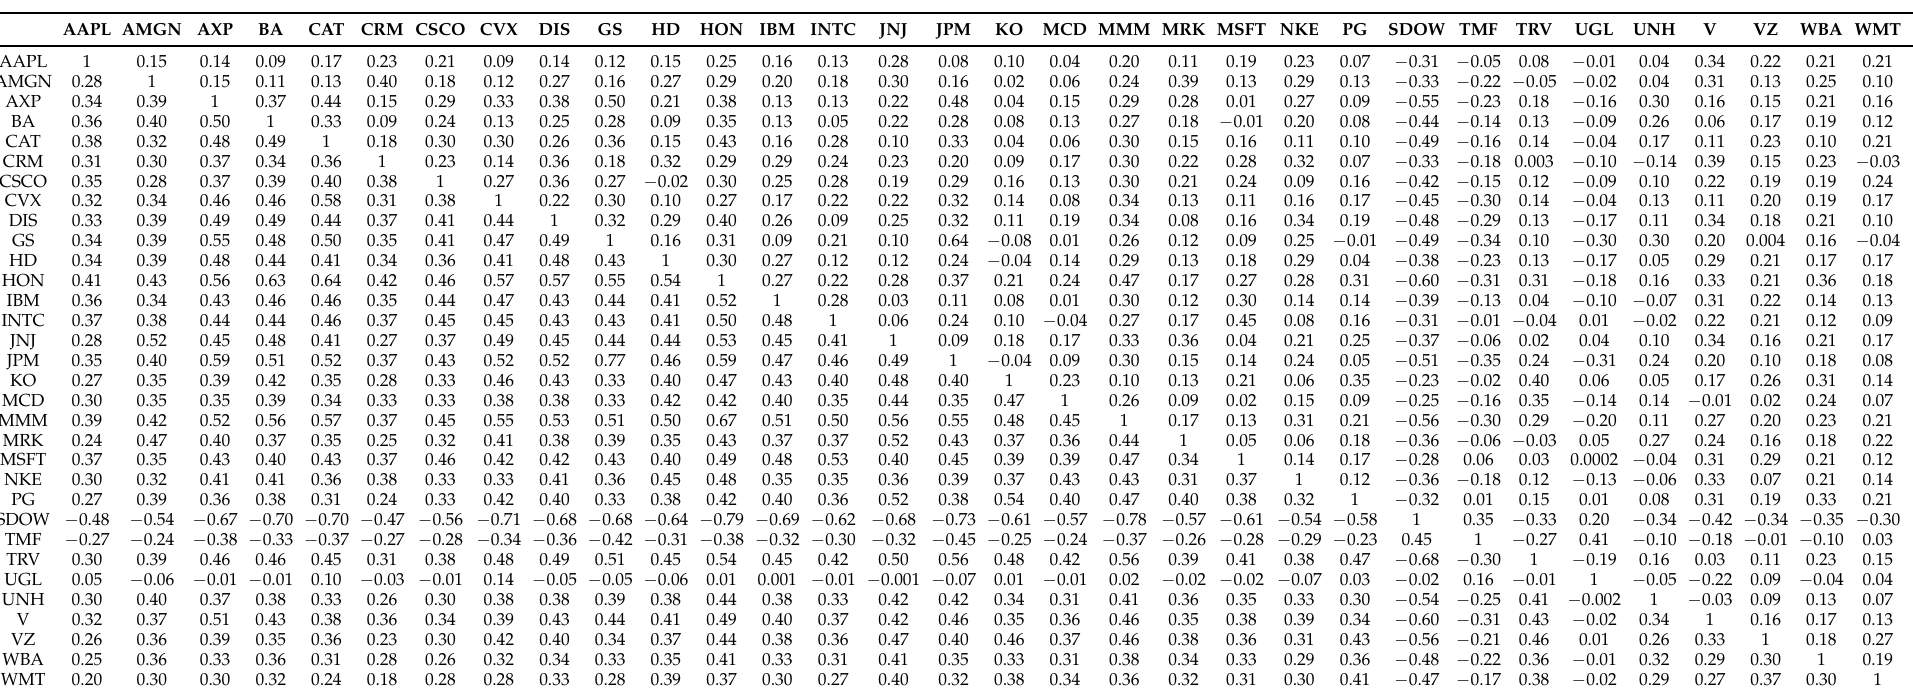
Table 3. Denoised correlation matrices of joint innovation in two